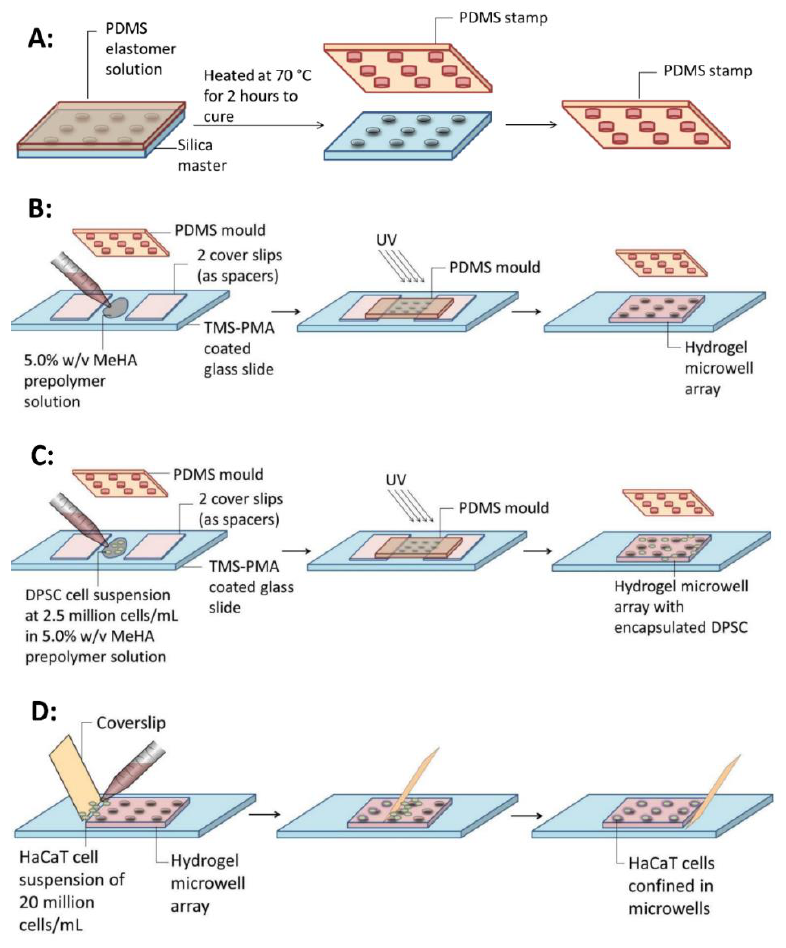
Figure 7. The schematic representation of microfabrication and cell seeding. ( A ) Fabrication of polydimethylsiloxane (PDMS) stamp using a SU-8 silicon master. ( B ) Fabrication of MeHA hydrogel microwell array by casting the photo-polymerization of 5.0% w / v MeHA prepolymer solution onto the PDMS stamp. ( C ) Encapsulation of DPSCs in MeHA hydrogel microwell array by suspending the cells inside prepolymer solution. The greyish spots represent the DPSCs encapsulated inside the hydrogels. ( D ) Seeding of HaCaT cells in microwells using a wiping method.